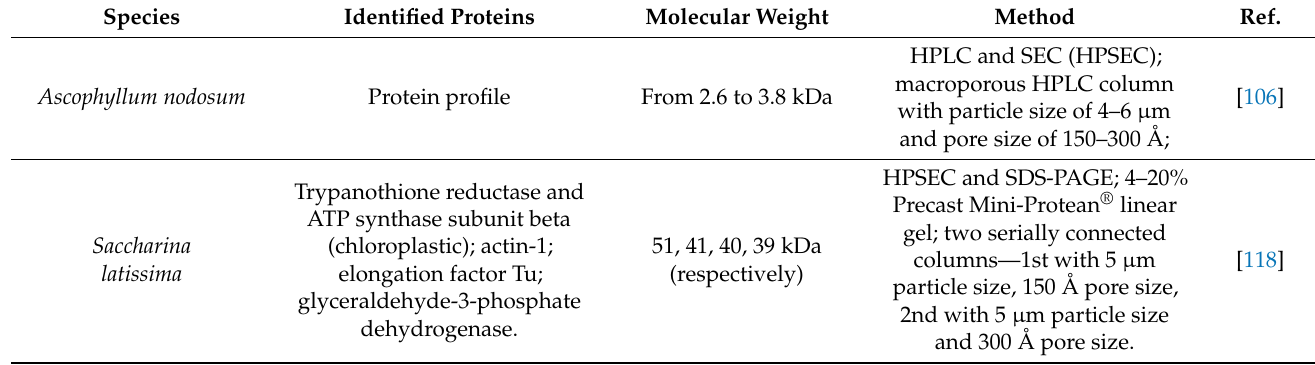
Table 6. Protein isolation and characterization using chromatographic methods in different seaweed species. Species Identified